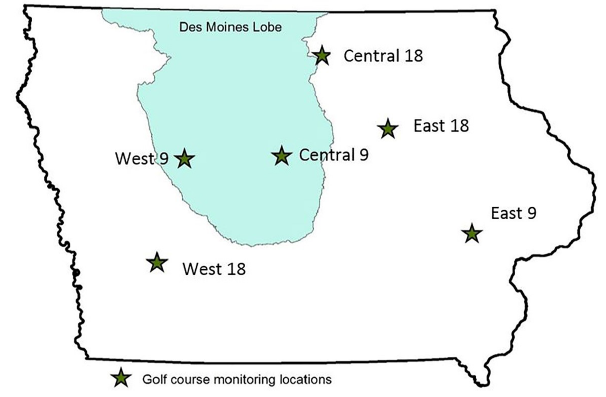
Figure 1. Location map showing the six golf courses chosen for this